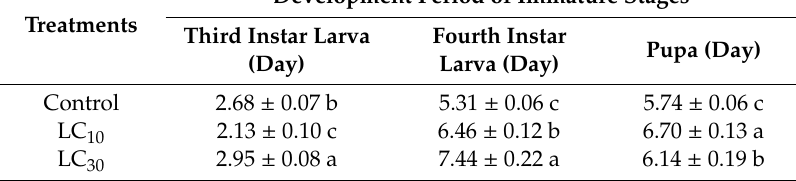
Table 2. Sublethal e ff ects of chlorpyrifos on the developmental period (mean ± SE) of pre-adult stages of H. axyridis .